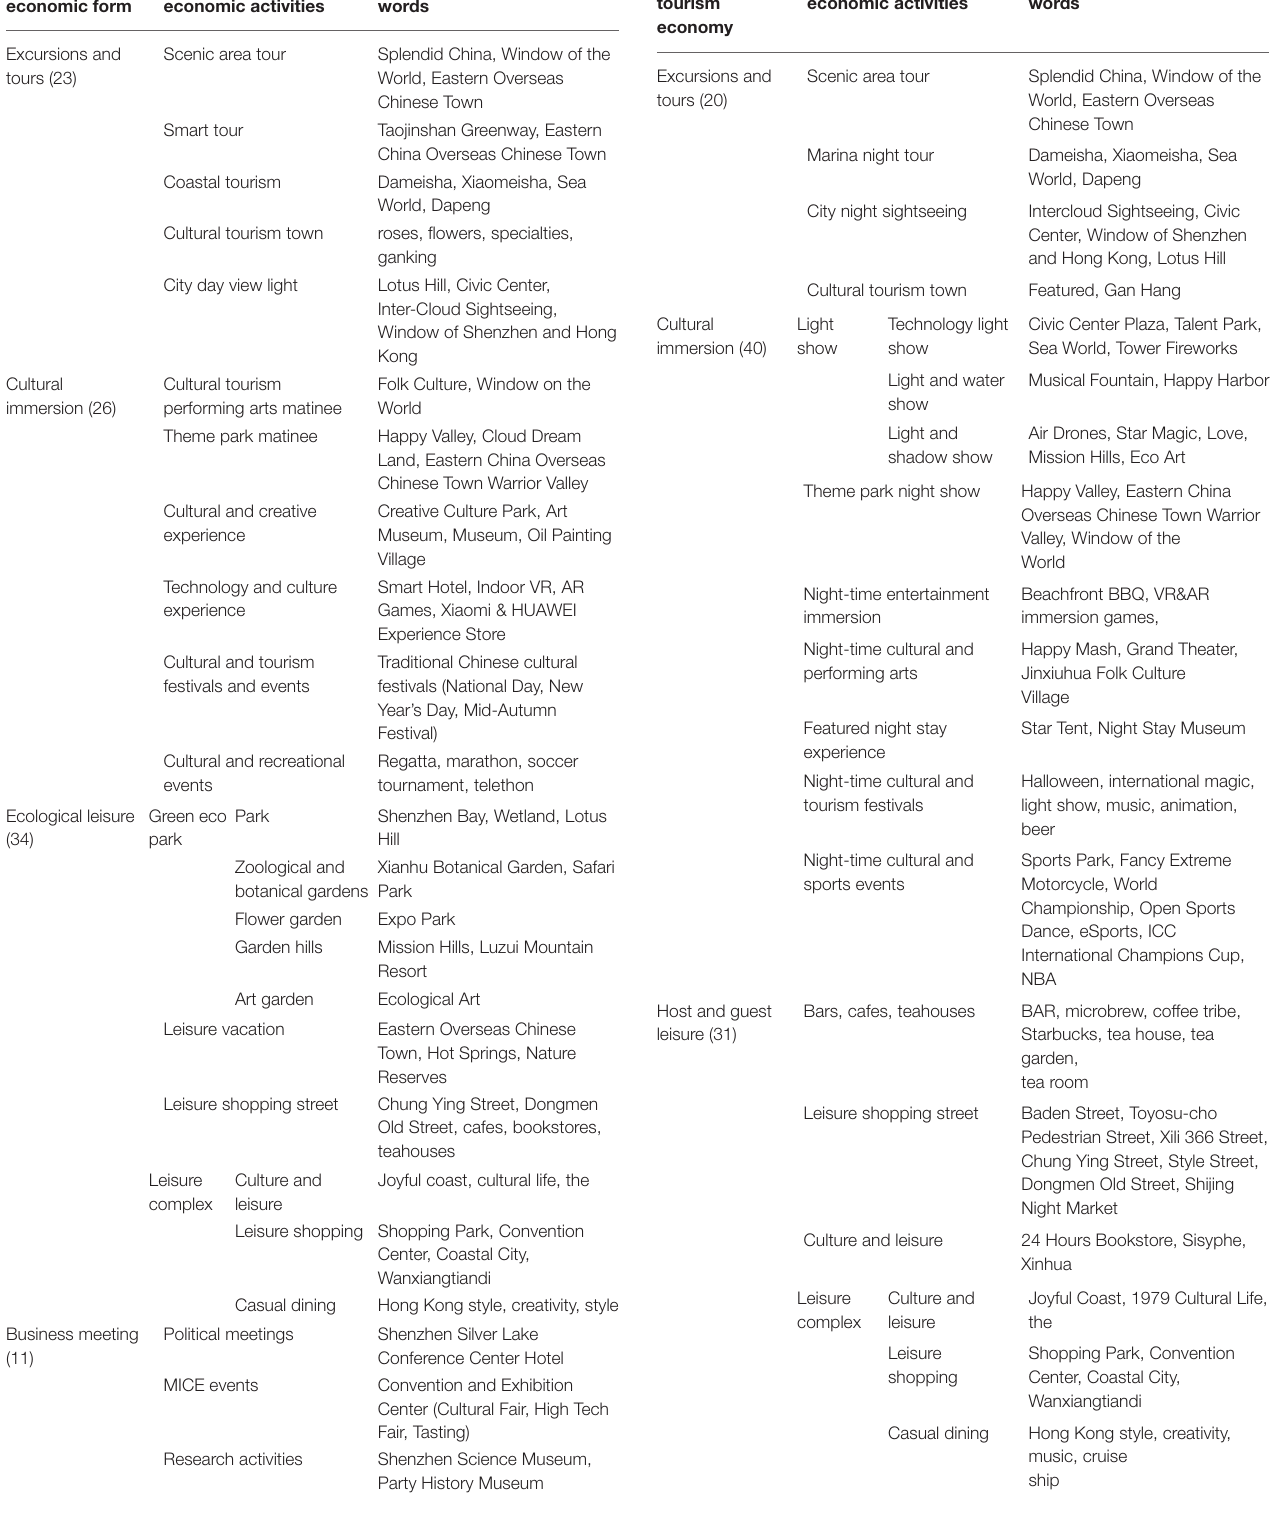
TABLE 6 | Classification of high-frequency characteristic words of night tourism economic form in Shenzhen. Forms of